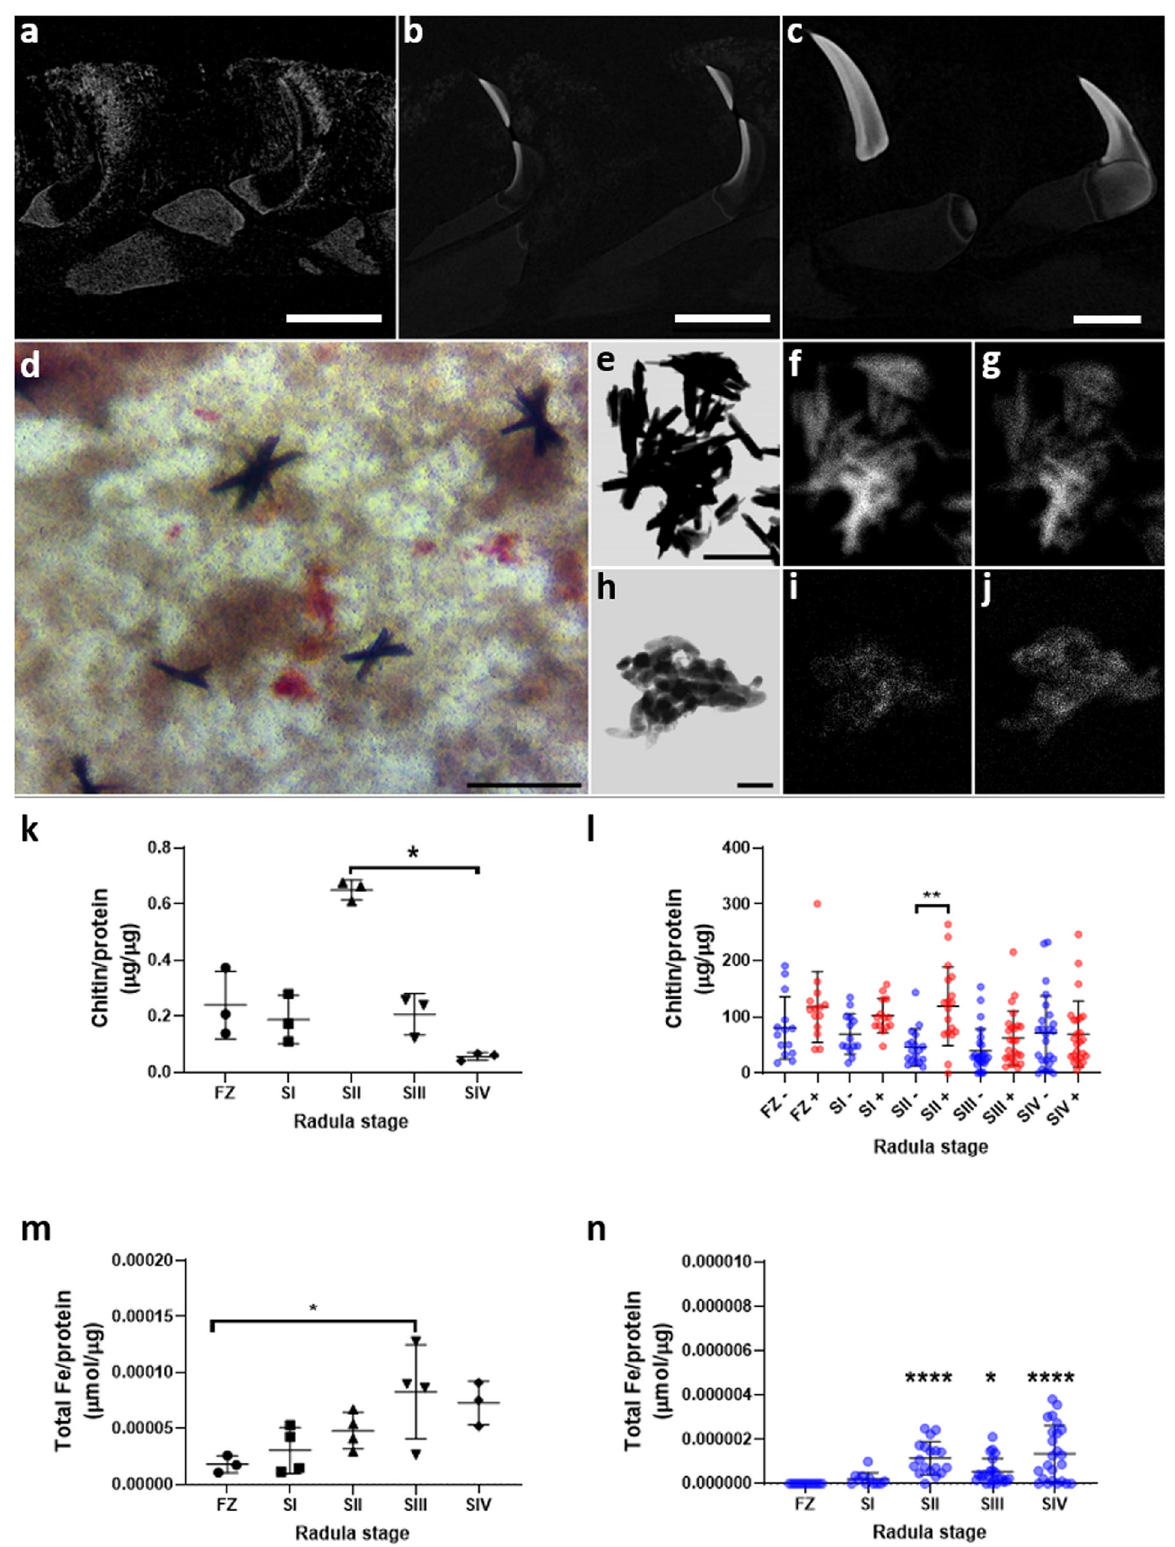
p = 0.0002 and p = 0.00161) and higher in Stage III than in Stages I and II (Supplementary Fig. 2d, p = 0.0006 and p = 0.0029). Chitobiosidase activity was higher in lysates from day 1 cells at Stage I than Stage III (Supplementary Fig. 2e, P = 0.0309); by day 14 in culture, activity had abated with no differences between cell populations (Supplementary Fig. 2f). Endochitinase activity